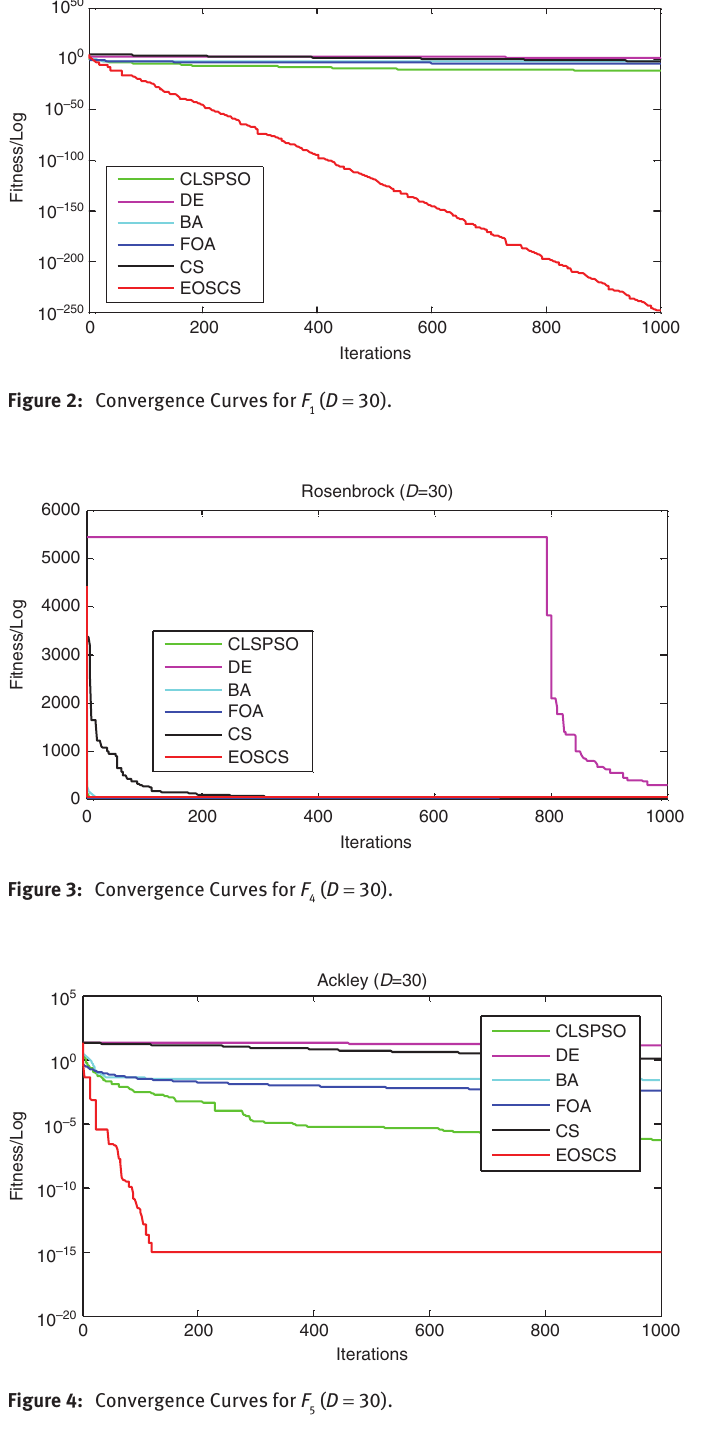
Figure 4: Convergence Curves for F